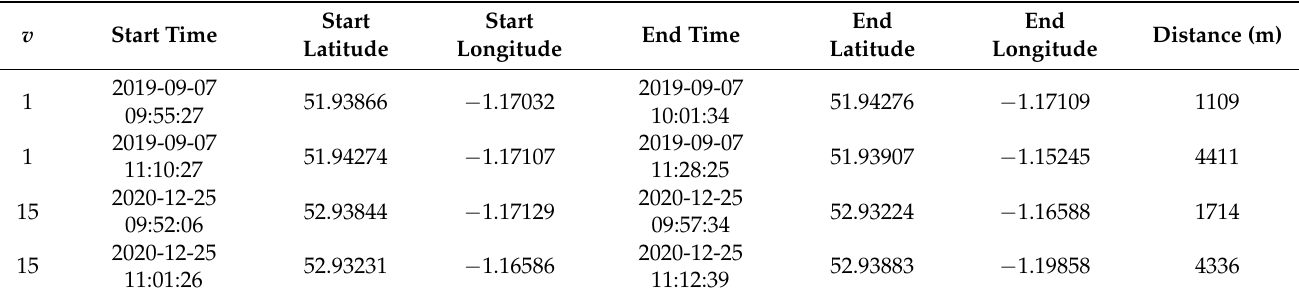
Table 1. Anonymised excerpt from the trip dataset, where v is the vehicle